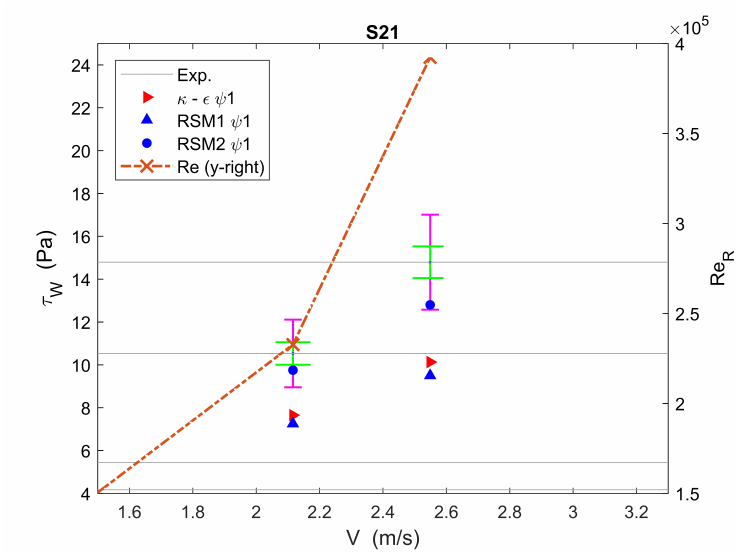
Figure 12. τ y = 0.43 Pa, m = 0.0831 Pas n , n = 0.5207 and D = 100 mm.